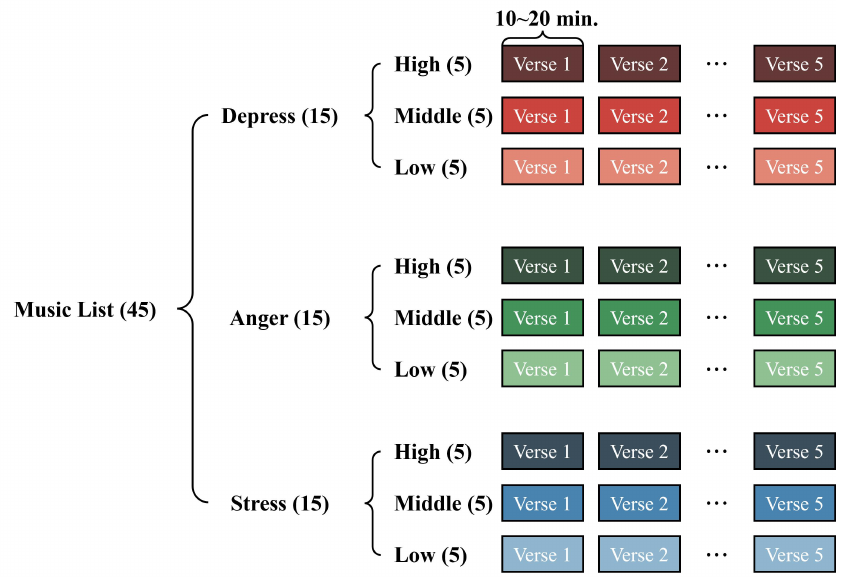
Figure 3. Composition of the DASS-21 scale with 45 music